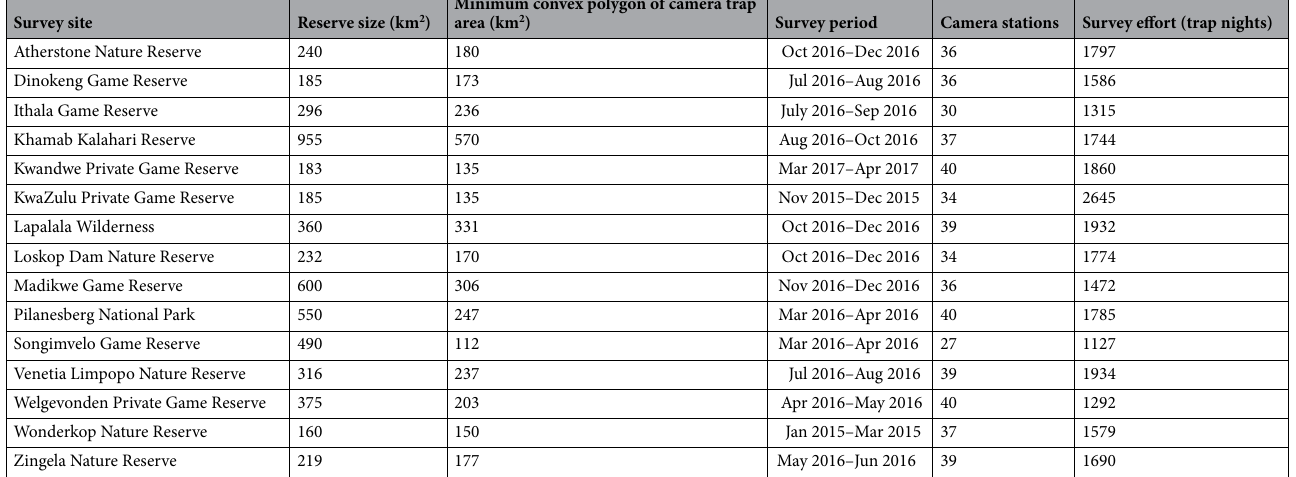
Table 1. Camera trap surveys in South Africa. Camera area is the minimum convex polygon area covered by camera trap stations. Survey effort is the total number of trap nights each camera survey was active. Camera area is the minimum convex polygon of the camera trap